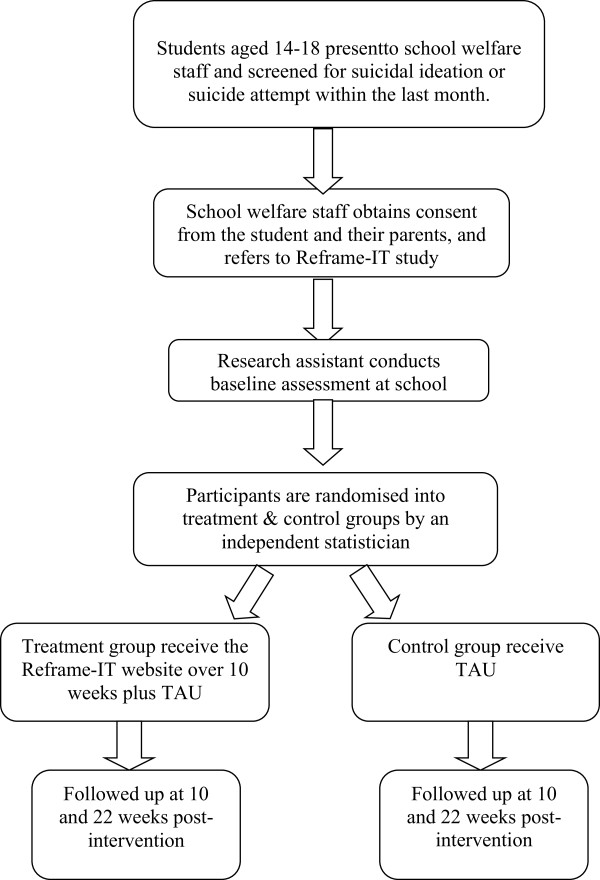
Study flow-chart.